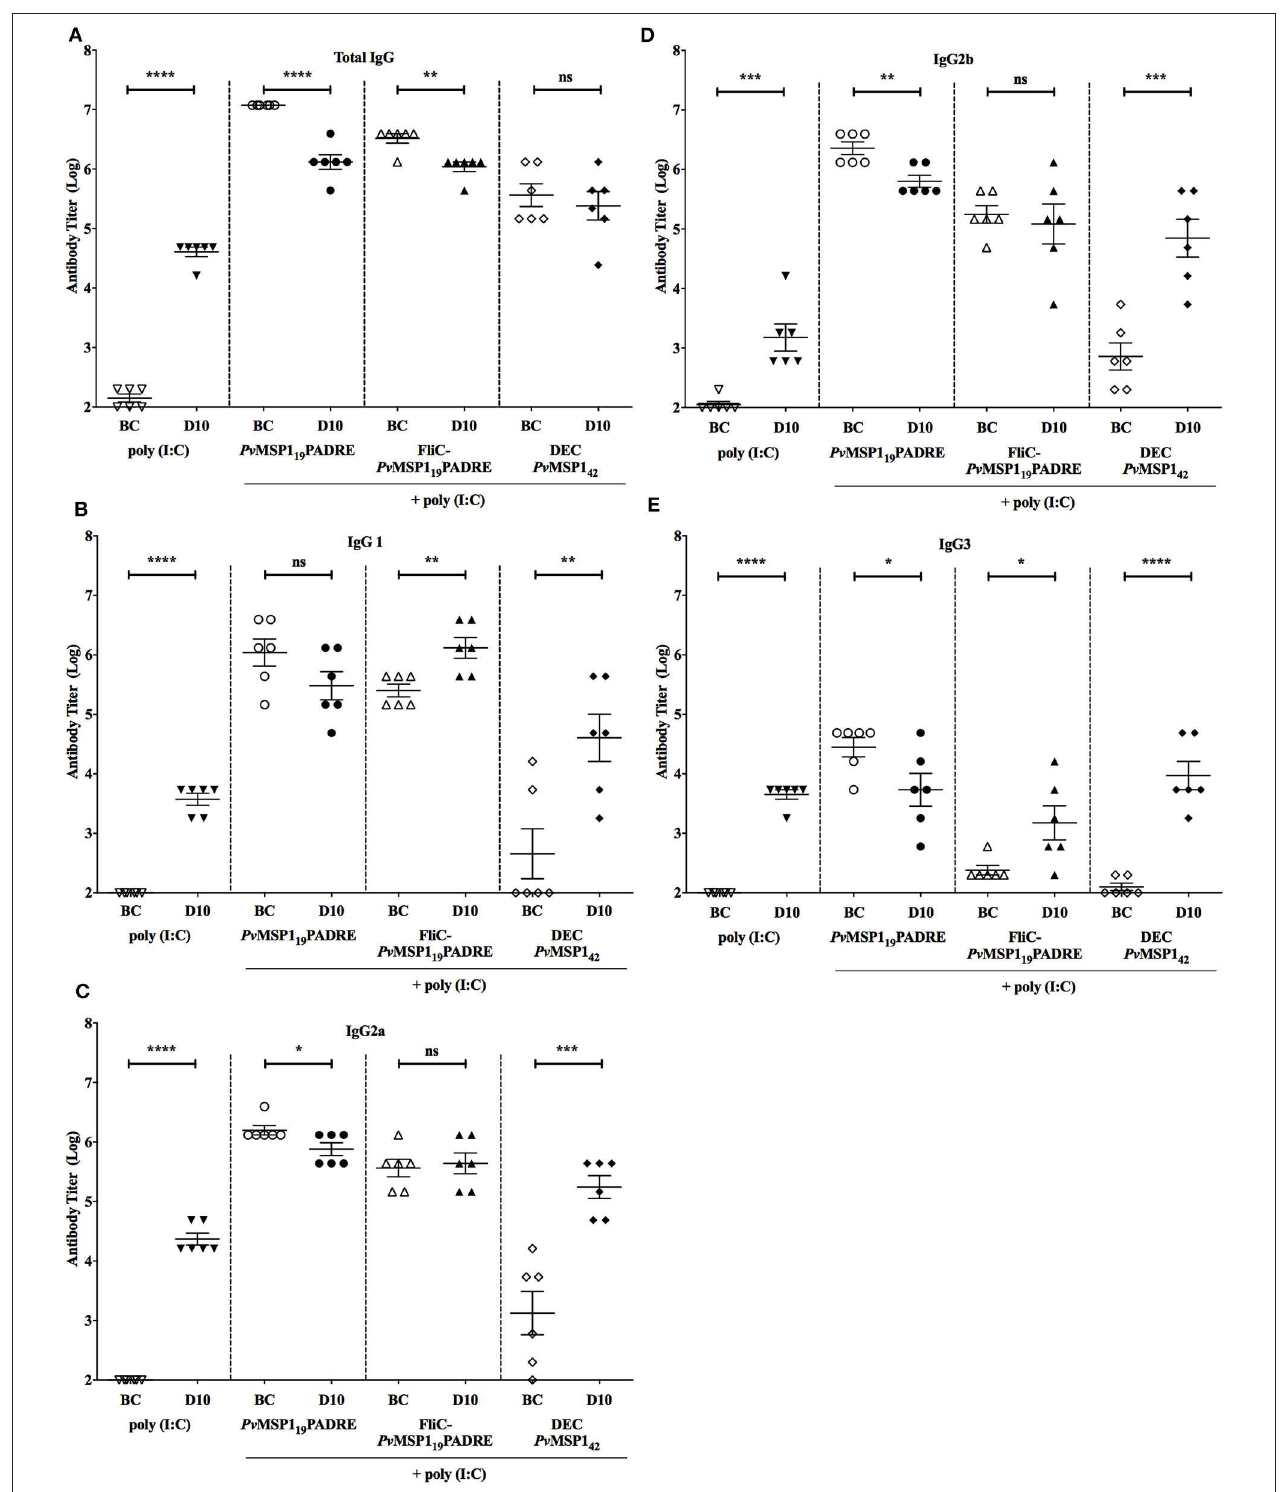
FIGURE 7 | Antibody responses in vaccinated mice before challenge and at day 10 post-challenge. Sera titers of total IgG (A) , IgG1 (B) , IgG2a (C) , IgG2b (D) , and IgG3 (E) of BALB/c mice in each indicated group ( n = 6) before challenge (BC) and at day 10 (D10) post-challenge. Unpaired t -test: ns, non-significant; * p < 0.05; ** p < 0.01; *** p < 0.001; and **** p < 0.0001.